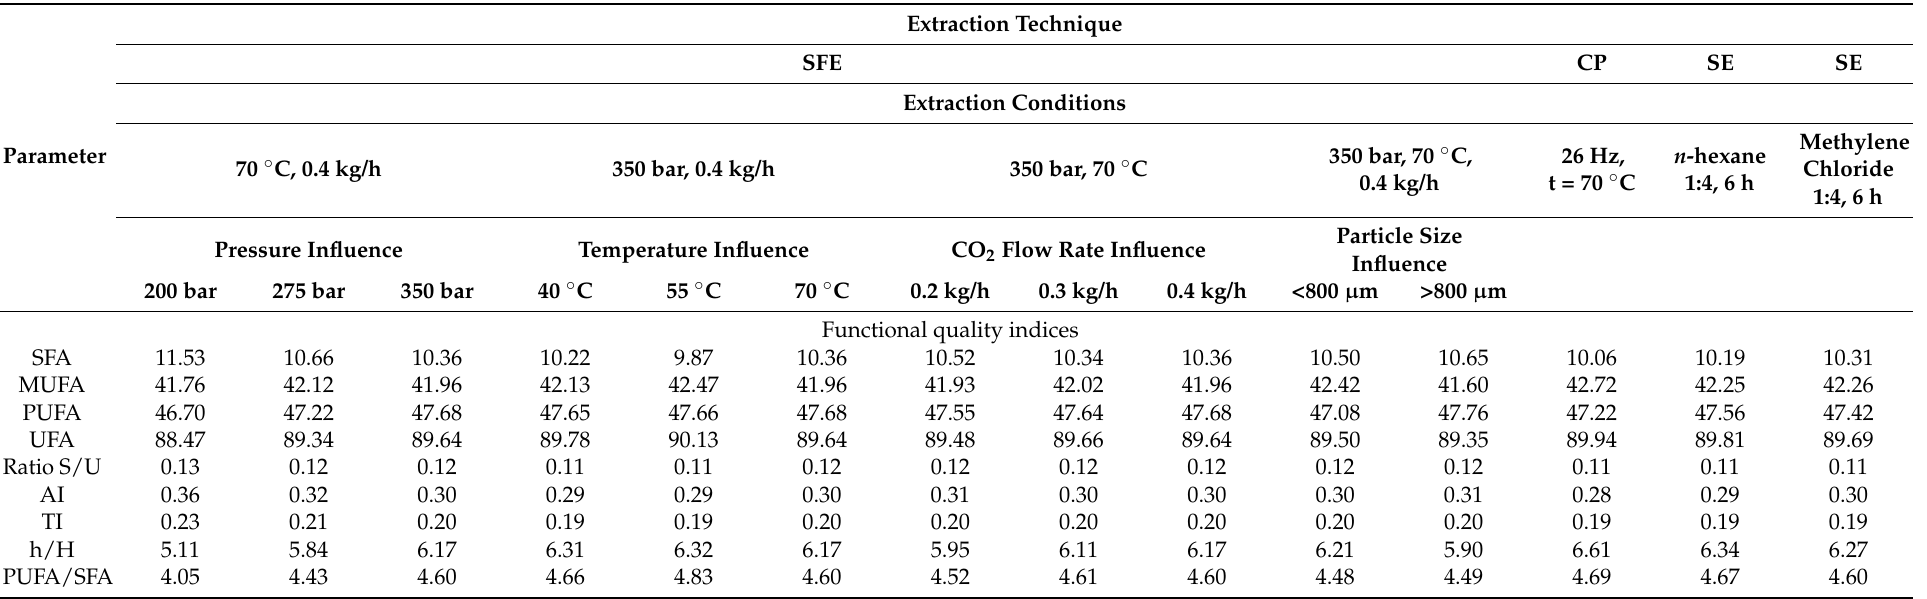
Table 3. Functional quality indices of cherry seed oils recovered by different extraction